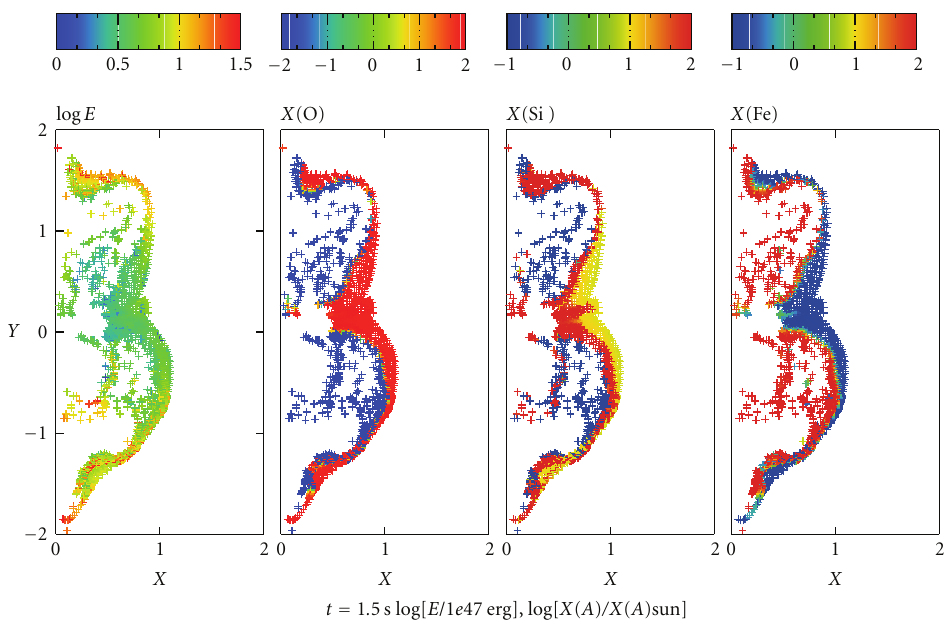
Figure 15: Distribution of internal energy (left panel) and abundances of the ejecta (O, Si, Fe from left to right, normalized to solar) when the nonspherical shock is propagating in the O-rich layers at around ∼ 20000 km along the pole ( ∼ 1.5 s after bounce). For this model, the input neutrino luminosity is set as L ν e = 4 . 5 × 10 52 ergs − 1 . Note that Fe in the right panel is the sum of 56 Fe, 56 Ni, and 54 Fe (from [248]).